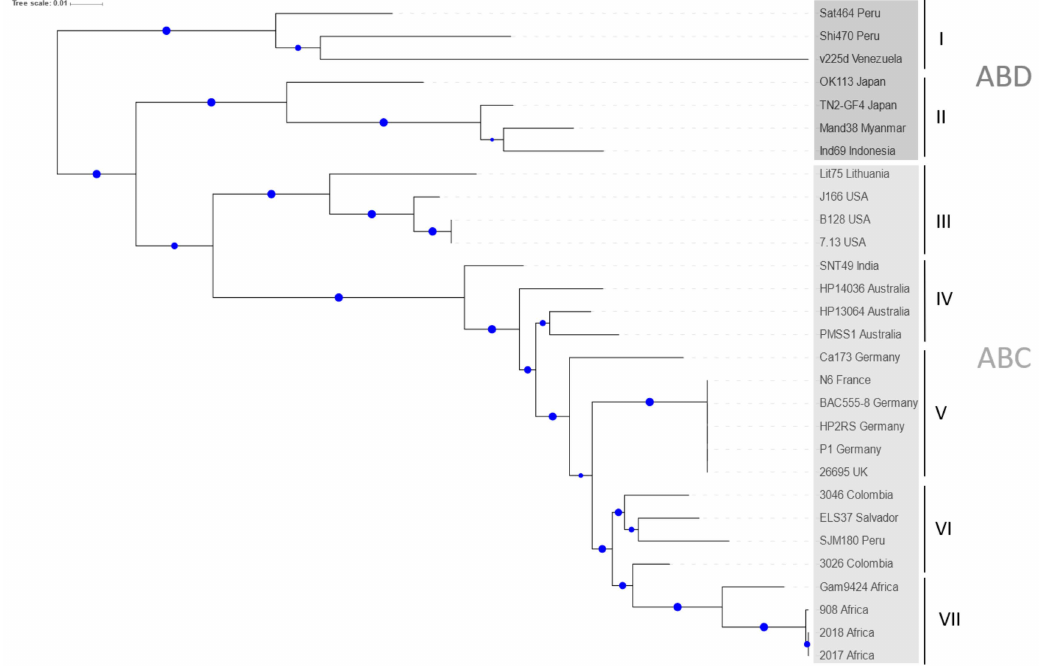
Figure 1. Neighbor-Joining tree of 29 non-redundant CagA protein sequences of patients from all continents. The strain names are indicated with the corresponding country when this information was available. Seven major clusters are identified and labelled with I to VII. Blue dots represent bootstrap values, the larger dots correspond to 100% and the smaller to 50%, respectively. The grayscale depicts ABD and ABC sequence types. The CagA protein sequences were downloaded from GenBank (Supplementary Table S1). For more information see